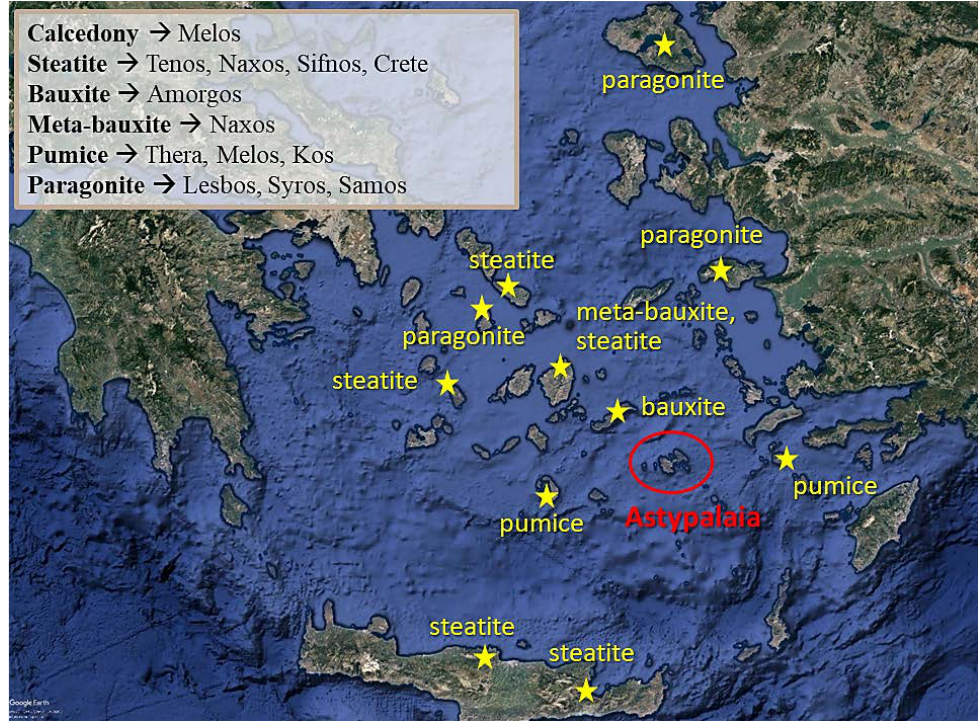
Figure 10. Oblique satellite image (Google Earth Pro) of the islands in the Aegean Sea, with the main occurrences of chalcedony, steatite, bauxite, meta-bauxite, pumice, and paragonite. Steatite, the so-called ‘soapstone’ due to its texture, is a magnesium-rich rock com- prising mostly talc and to a lesser extent other minerals including amphiboles, chlorite and serpentine. The application of the NIRS at the steatite beads indicated the presence of talc, displaying the related characteristic absorption features at the spectra. In the Aegean Sea, steatite occurs at Tenos, Naxos, Sifnos, and Crete. According to [45], the mineralogical composition of steatite in Crete varies, exhibiting mineralogical heterogeneity, related to the complex geologic structure of the island and the associated host rocks. The main